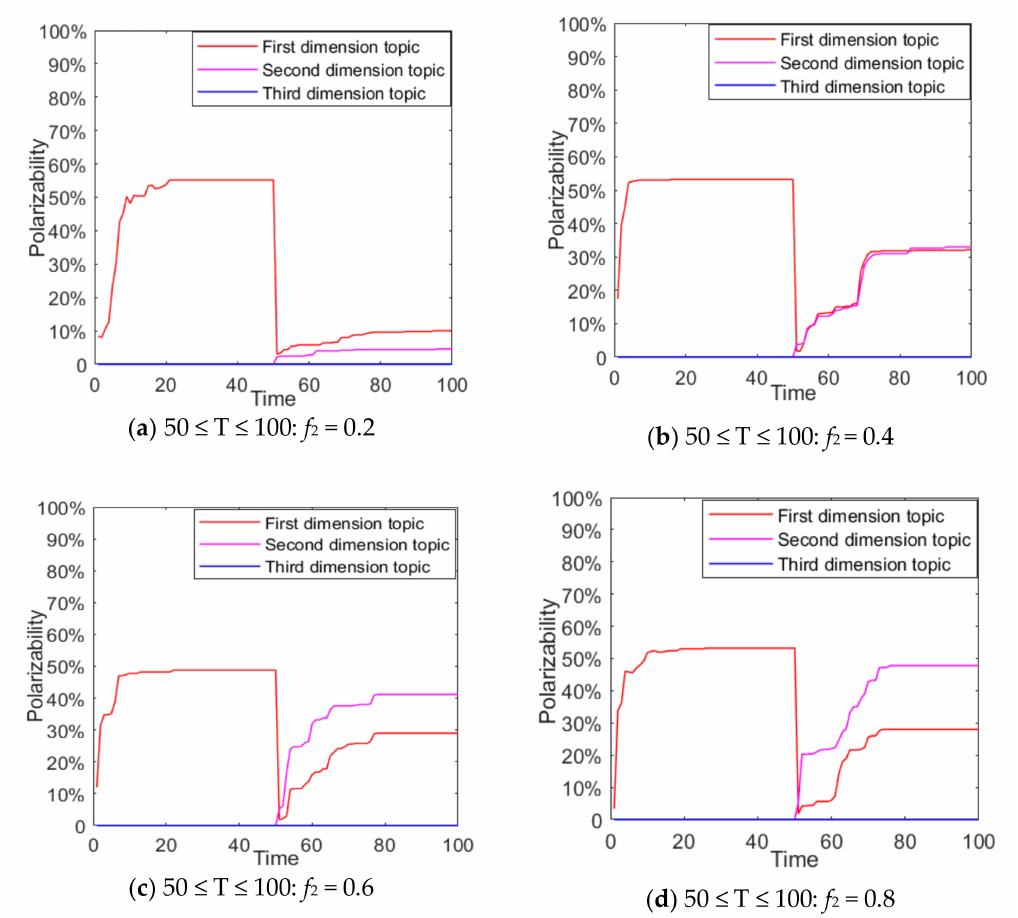
Figure 17. The polarizability curve of group attitude under different external information intensity at different